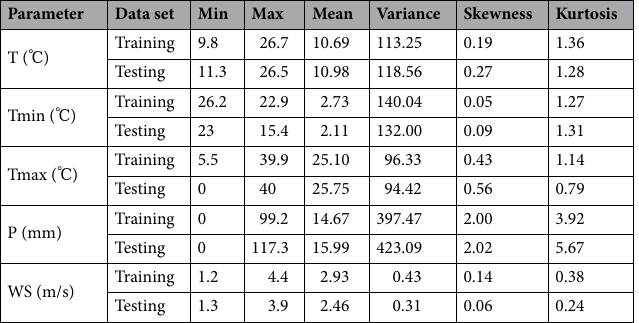
Table 1. The statistical characteristics of the collected meteorological